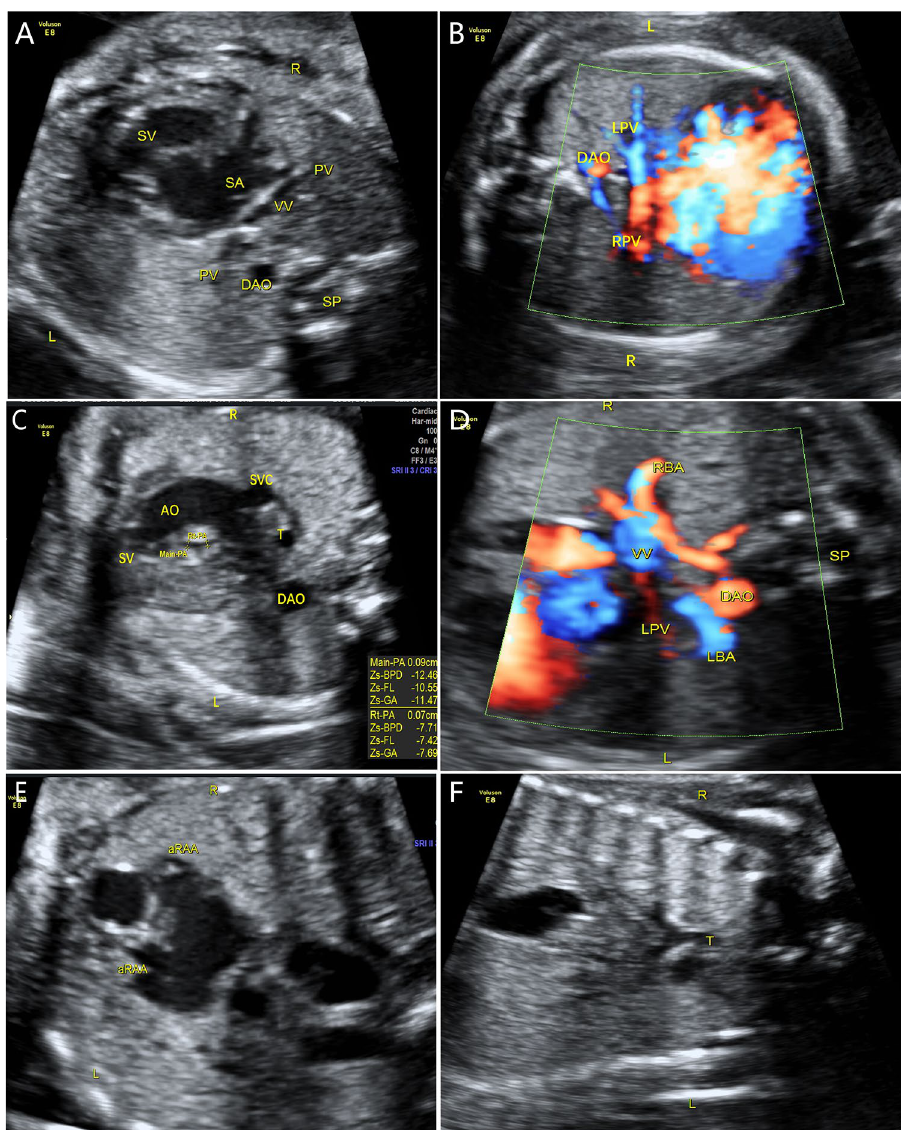
Figure 6. Prenatal ultrasound diagnosis of fetal infracardiac TAPVC with complex malformations. ( A , B ) Two-dimensional and color Doppler flow imaging showing a single atrium, single atrioventricular valve, single ventricle, and left and right PVs forming a common PV trunk, accompanied by increased posterior left atrium index. The pulmonary artery and aorta both originated from a single ventricle and pulmonary atresia was observed. ( C , D ) A collateral blood supply from the descending aorta in both lungs was seen in the cross section of the heart. ( E ) Both left and right atrial appendages were anatomically right atrial appendages. ( F ) Left and right main bronchi were